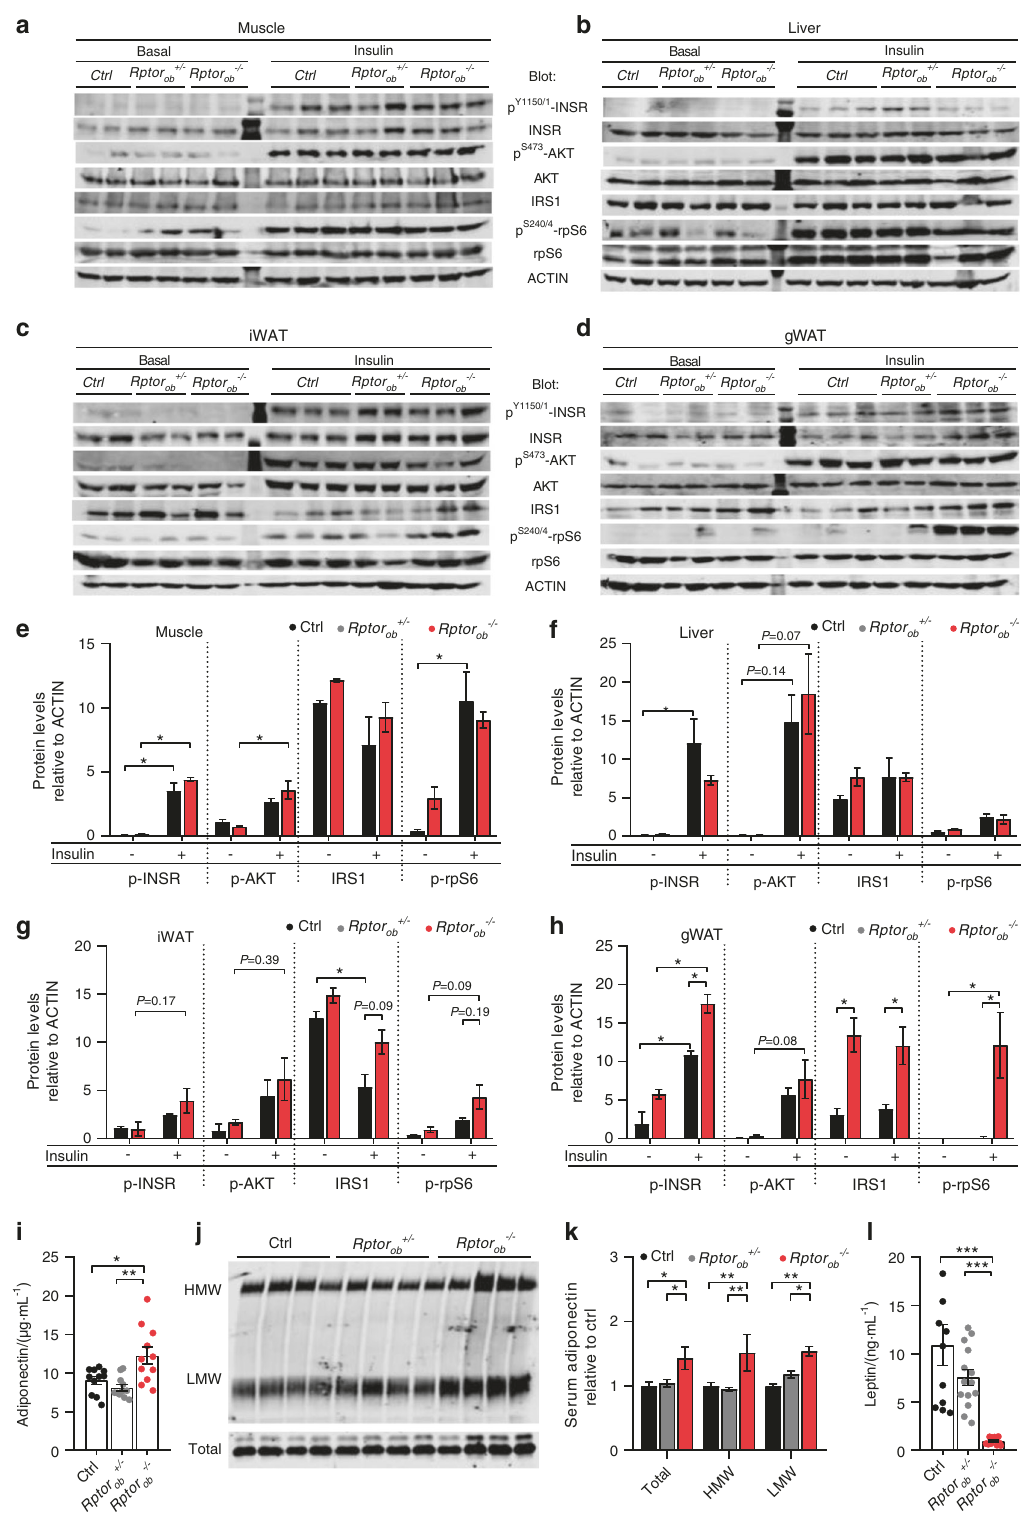
Fig. 5 Increased insulin signaling in adipose tissue depots and elevated serum adiponectin in HFD-fed Rptor ob − / − mice. Western immunoblot analysis of indicated protein levels in skeletal muscle ( a ), liver ( b ), iWAT ( c ), and gWAT ( d ) tissues from 18-week-old HFD-fed mice collected after a 6-h fast, under either basal (6-h fast + PBS; n = 2/genotype) or insulin-stimulated (6-h fast + insulin stimulation; n = 2 – 3/genotype) conditions. e – h Quantitative analysis of indicated protein levels from a – d , relative to ACTIN. i Serum adiponectin levels ( n = 10 – 15/genotype). j Western immunoblot analysis of HMW, LMW forms and total adiponectin levels in sera from 18-week-old HFD-fed mice ( n = 4/genotype). k Quantitative analysis of protein levels from j . l Serum leptin levels ( n = 11 – 14/genotype). All panels except e – h : data are expressed as mean ± SEM. * P < 0.05, ** P < 0.01, *** P < 0.001, one-way ANOVA with Tukey ’ s post hoc test. e – h P < 0.05, two-way ANOVA with Tukey ’ s post hoc